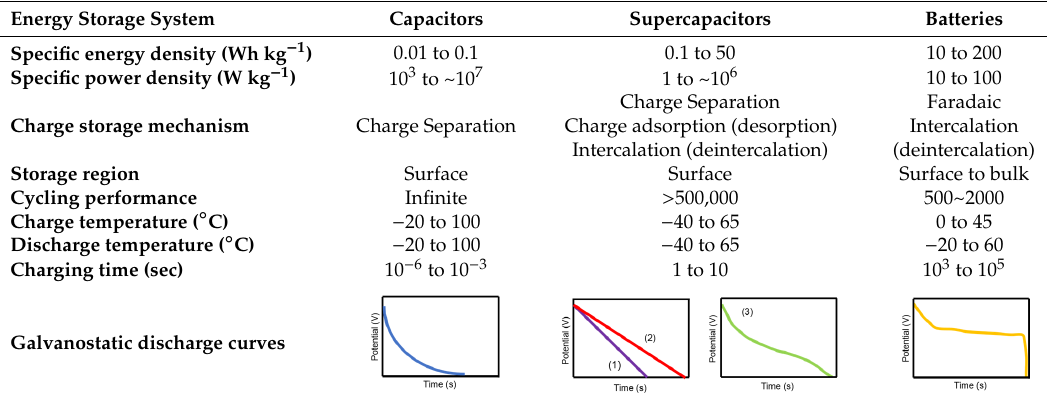
Table 1. Description of the properties of energy storage systems.